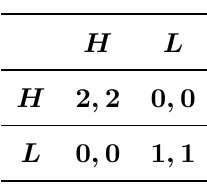
Table 7. A high-low